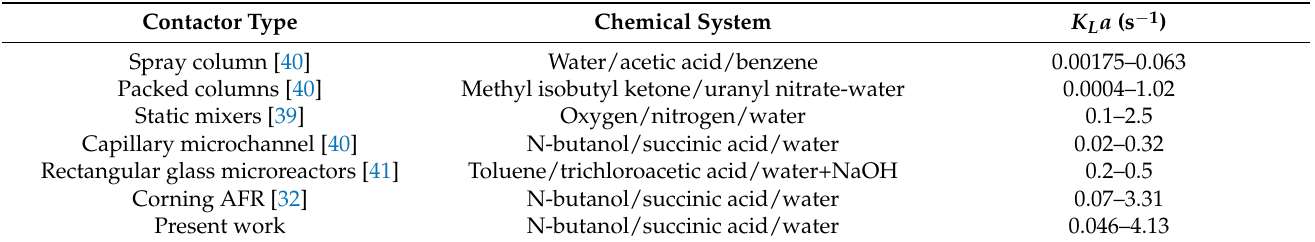
Table 4. Comparison of the volumetric mass transfer coefficients in liquid − liquid contactors. Contactor